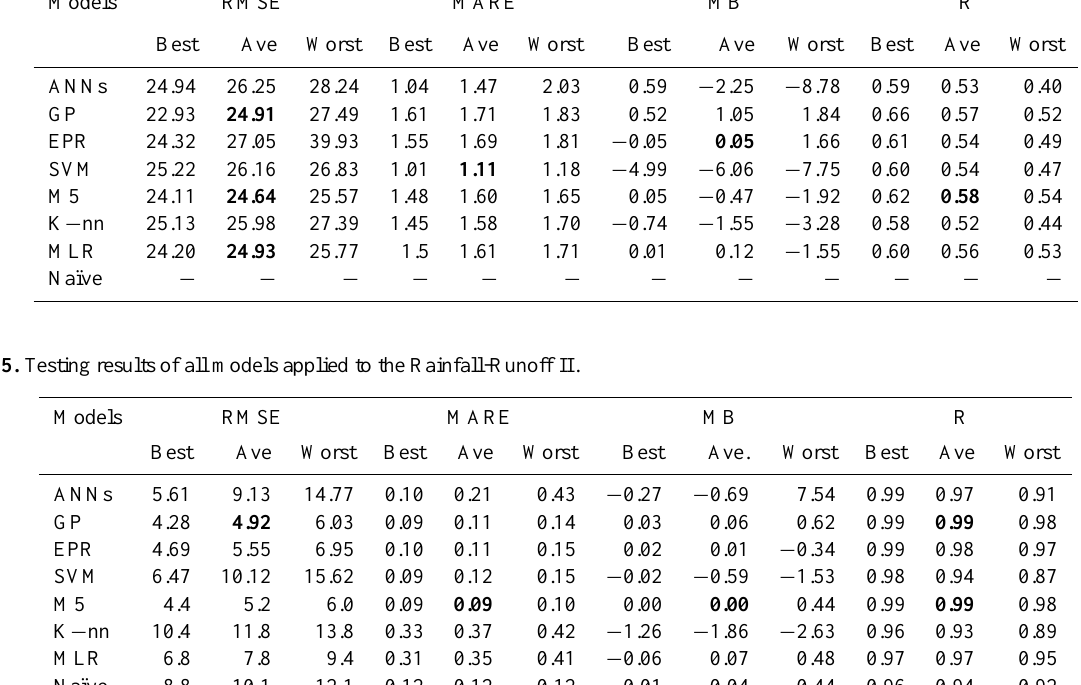
Table 14. Testing results of all models applied to the Rainfall-Runoff I . Models